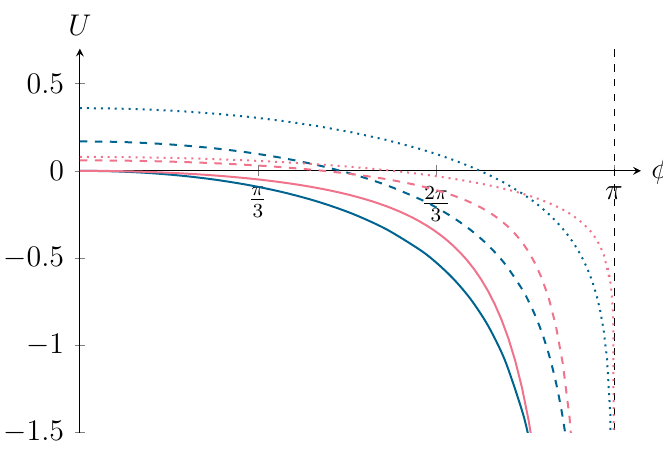
Figure 3 . In blue, the potential U ( φ, θ ) /N at large N obtained numerically from (3.26) for different values of θ : θ = 0 (solid), 2 π/ 3 (dashed) and π (dotted). Notice the divergence near φ = π , which is captured by the antiparallel planes limit (3.41). The potential at N = 1 for the same values of θ (2.11) is in